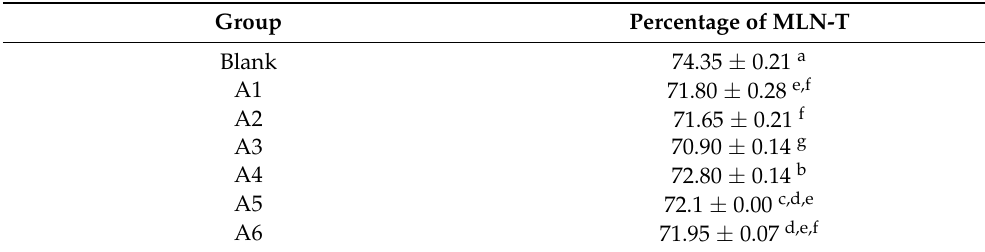
Table 4. Proliferation of CFSE-positive MLN cells (72 h proliferation assay) was evaluated by flow cytometry. The results were represented as the mean ± SD ( n = 3, whereas different letters indicate significance in each column, as determined by two-way analysis of variance (ANOVA) with Duncan’s post-test ( p < 0.05). SD, standard deviation). CFSE, 5-(and 6)-carboxyfluorescein diacetate, succinimidyl ester. MLN, mesenteric lymph node.